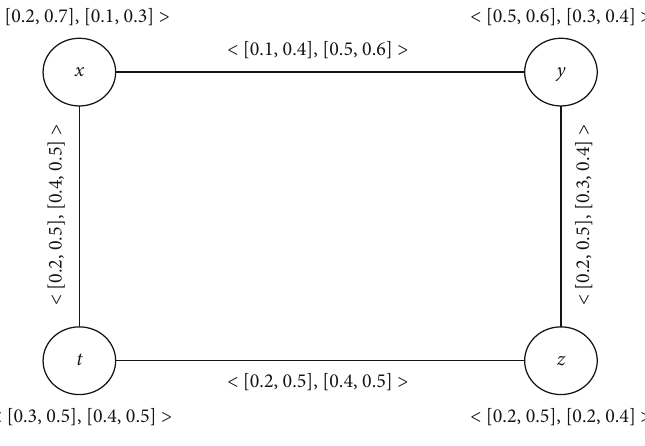
Figure 4: An IVIFG G for strong independent arc cover Table 5: Calculating the weight of strong arc cover sets Y .